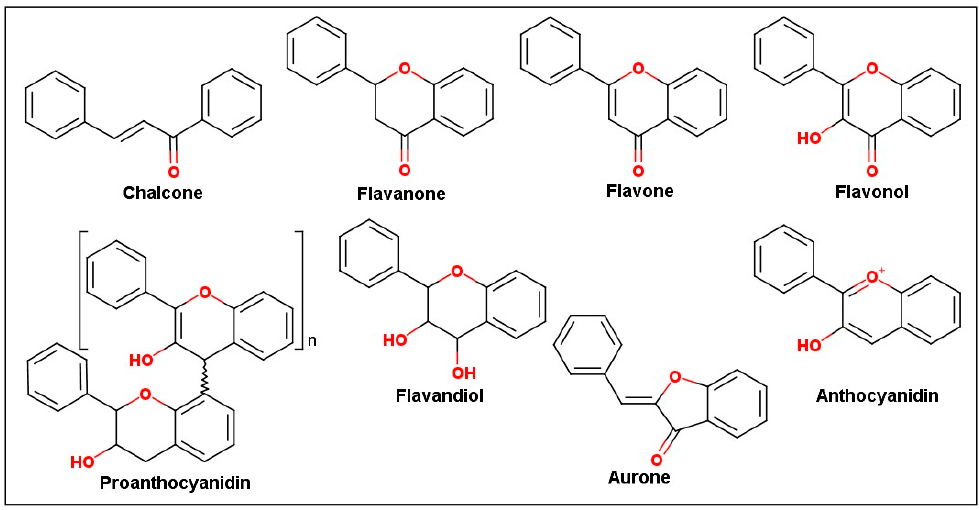
Figure 2. Major subclasses of flavonoid structures [3,24].